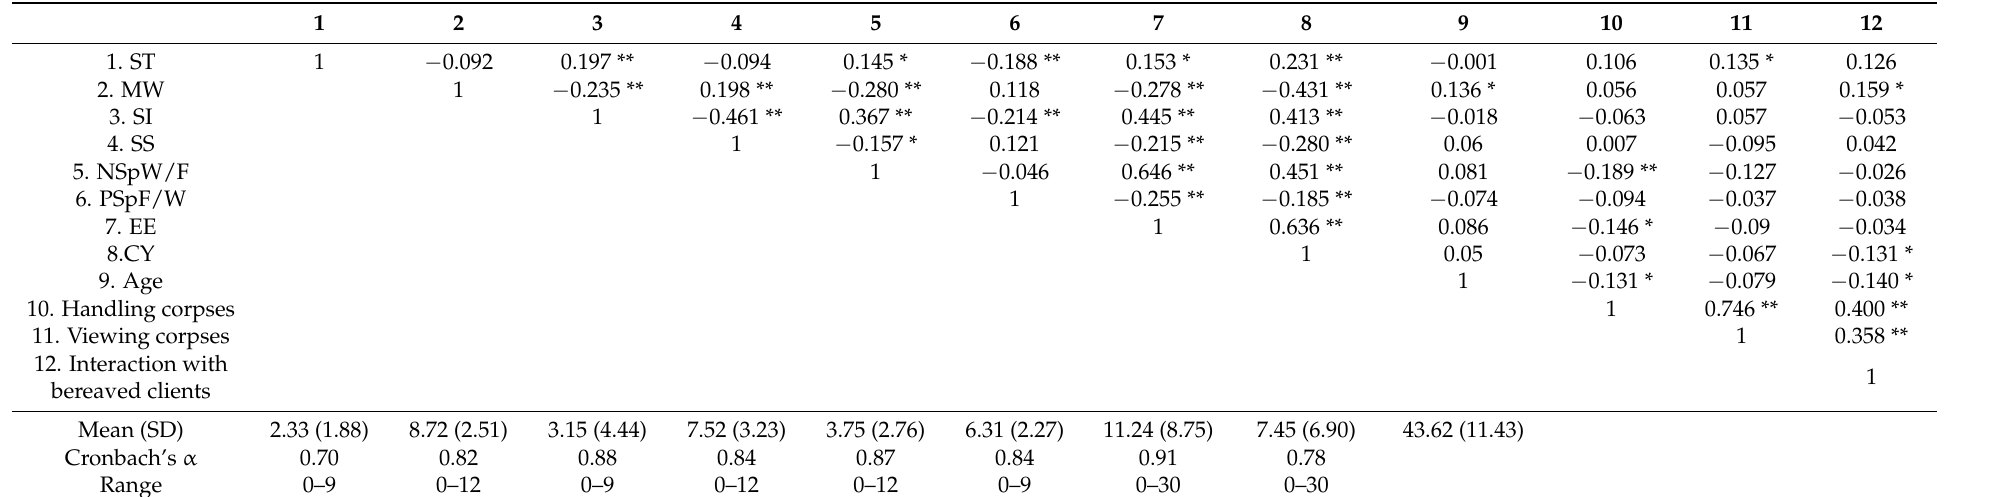
Table 1. Descriptive statistics and correlations among the study